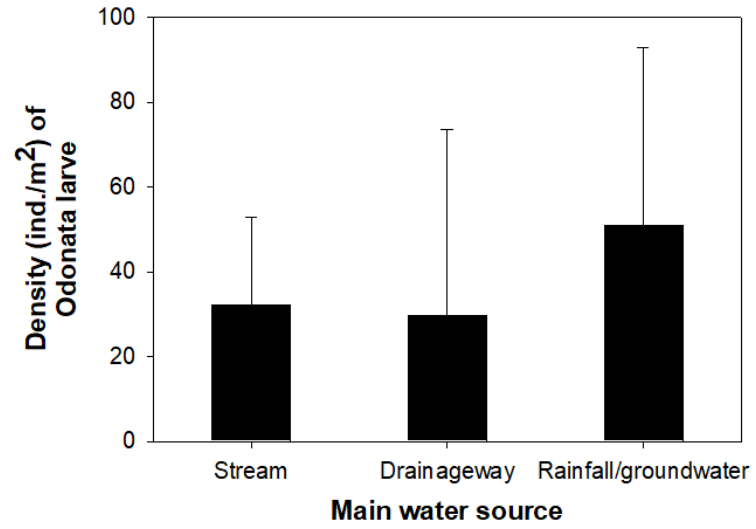
Figure 3. Density of Odonata larvae according to three main water sources.